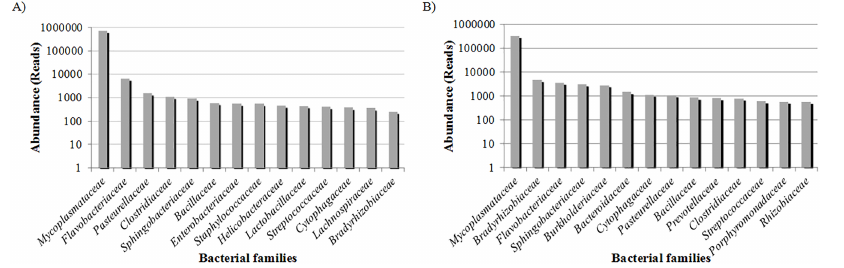
Fig 3. Z-score of the ratio of mapped reads between samples. The x-axis shows the most prevalent bacteria species reported. The y-axis shows the Z-scores from the normalized ratio of mapped reads.